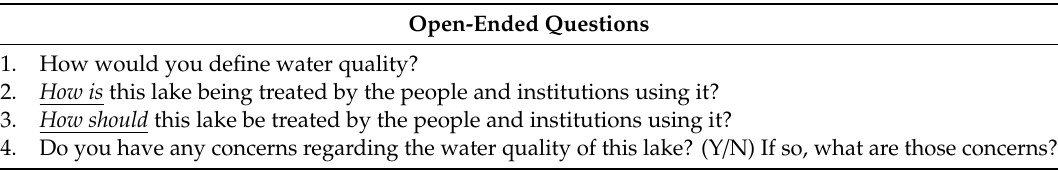
Table 1. Open-ended survey questions.